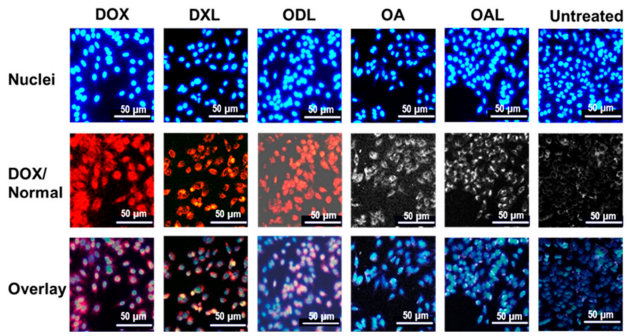
Figure 7. Drug uptake in HepG2 cells after 24 exposure of drug treatments, except DOX (4 h exposure) at drug conc. = IC 40 under fluorescence microscope (magnification 10 × ).